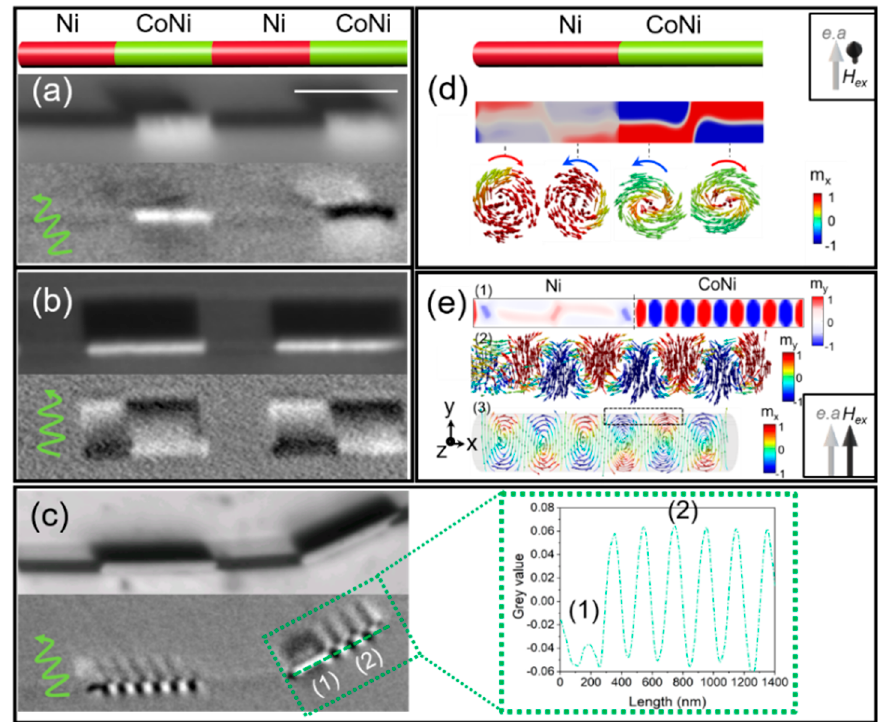
Figure 15. Chemical contrast (upper images) and XMCD-PEEM (lower images) contrast at Co L 3 -edge of CoNi(x)/Ni(1000 nm) multisegmented NWs with ( a ) x = 600 nm, ( b ) x = 1200 nm and ( c ) x = 1400 nm. The inset in ( c ): XMCD profile of the CoNi segment at the right side in ( c ) presented at the position marked by the dashed horizontal green line. ( d ) Micromagnetic simulations of multi-segments with the applied magnetic field perpendicular to both, nanowire and magnetocrystalline easy axis (e.a.). ( e ) Micromagnetic simulations of multi-segments with the applied magnetic field parallel to the magnetocrystalline easy axis and perpendicular to the nanowire. Scale bar: 1 μ m. Adapted with permission from ref. [73]. Copyright 2020 American Chemical Society.